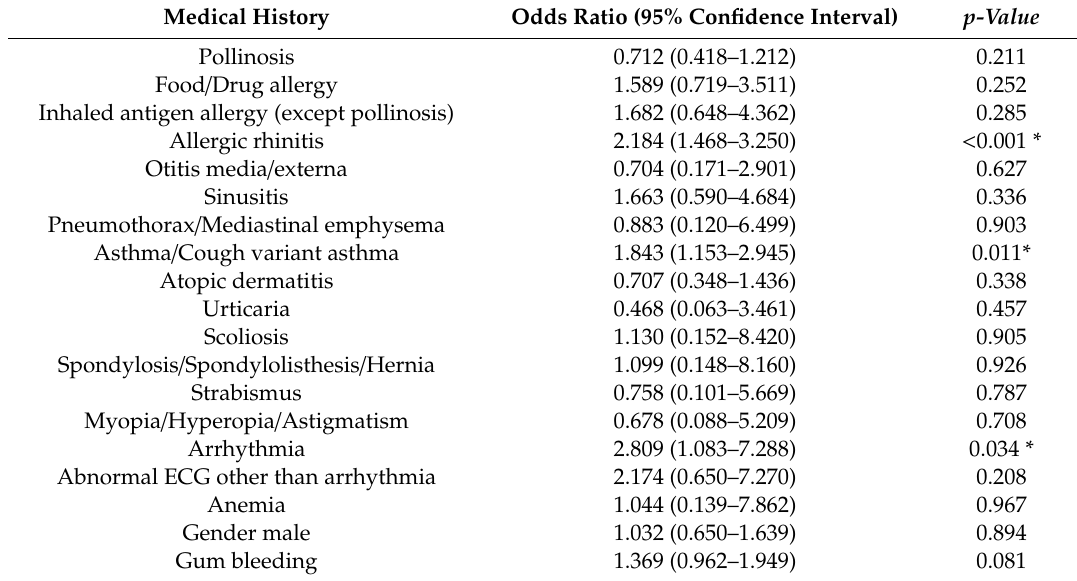
Table 3. Results of multivariate analyses of the associations between an awareness of malocclusion and common systemic diseases in